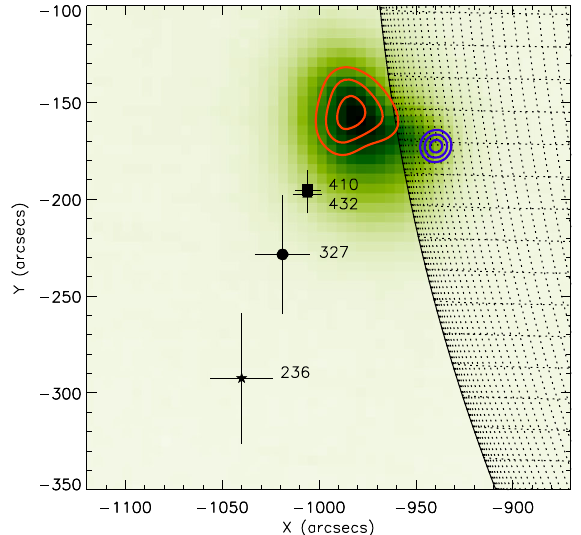
Fig. 18 The flare SOL2006-12-05 occurred at the solar limb. The averaged centroid positions of radio emission observed by the Nançay Radioheliograph and indicated in MHz are shown on a GOES/SXI image. The contours show RHESSI observations at 18–25 keV ( red , coronal source, mostly thermal), and 25–50 keV ( blue , non-thermal, footpoint source). Image reproduced by permission from Benz et al.